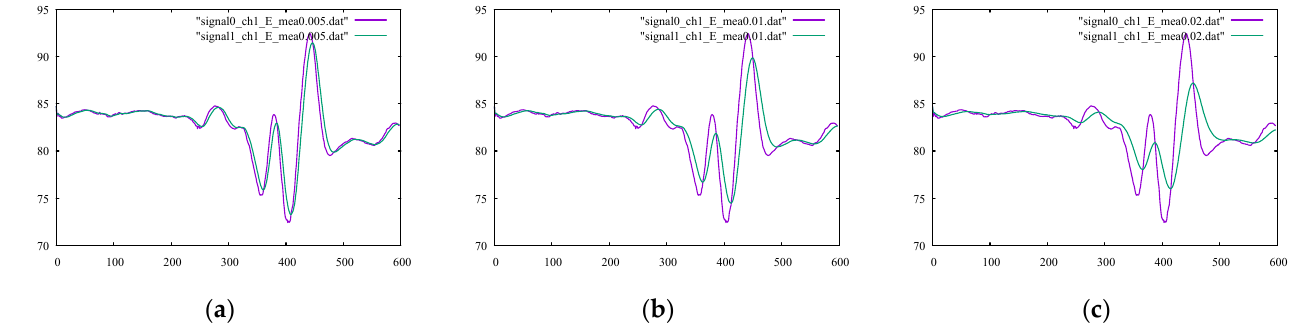
Figure 10. Original noisy motion signal from channel 1 of the root-joint of the kicking character versus the smoothed signal via the Kalman filter using ( a ) E mea = 0.005, ( b ) E mea = 0.01 and ( c ) E mea = 0.02.